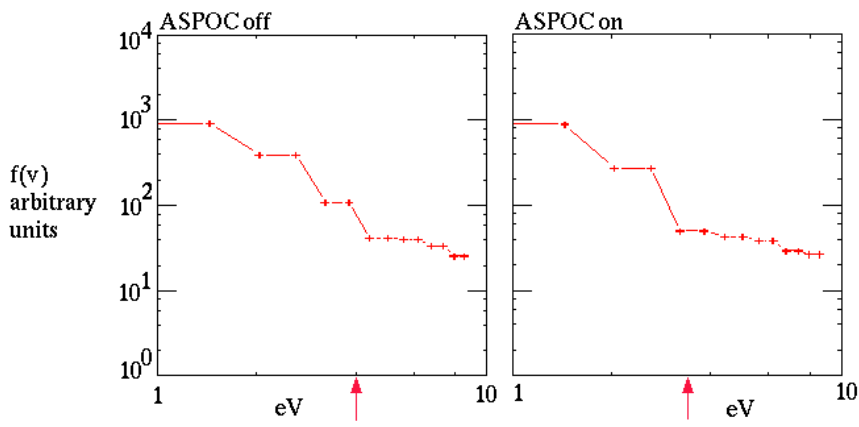
Fig. 5. Energy spectrum showing the spacecraft potential as a change of gradient, before and after ASPOC is switched on, 17 January 2001. The arrow marks the EFW spacecraft potential in each